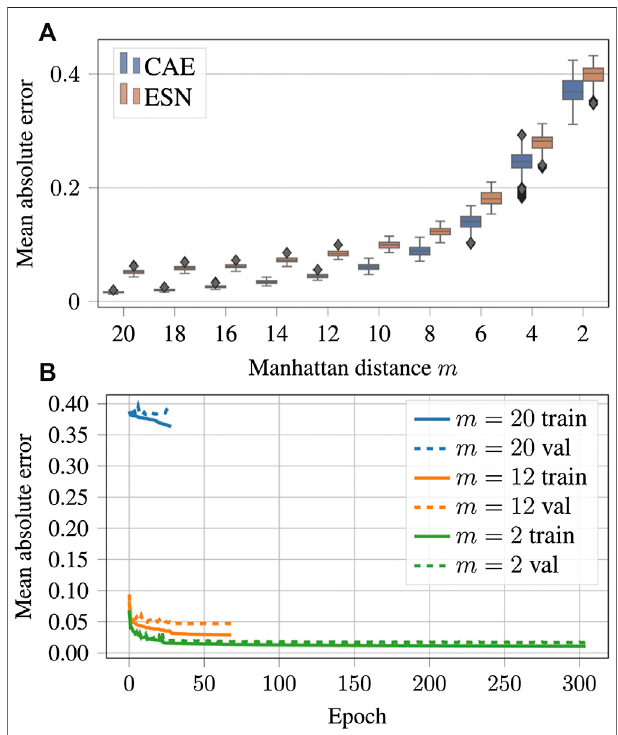
FIGURE 11 | (A) Mean absolute errors of reconstructions using CAE or ESN from data blurred with different values of the low-pass fi lter parameter m . Like in Figure 9B boxes are horizontally shifted for better visibility. A tabular overview of the values can be found in Table 3 . (B) Evolution of the loss function values over the training epochs for blurred data. Training was always terminated by reaching the early stopping criterion, de fi ned in Section 3.1 . One epoch trained approximately 108 s on a GTX 1080